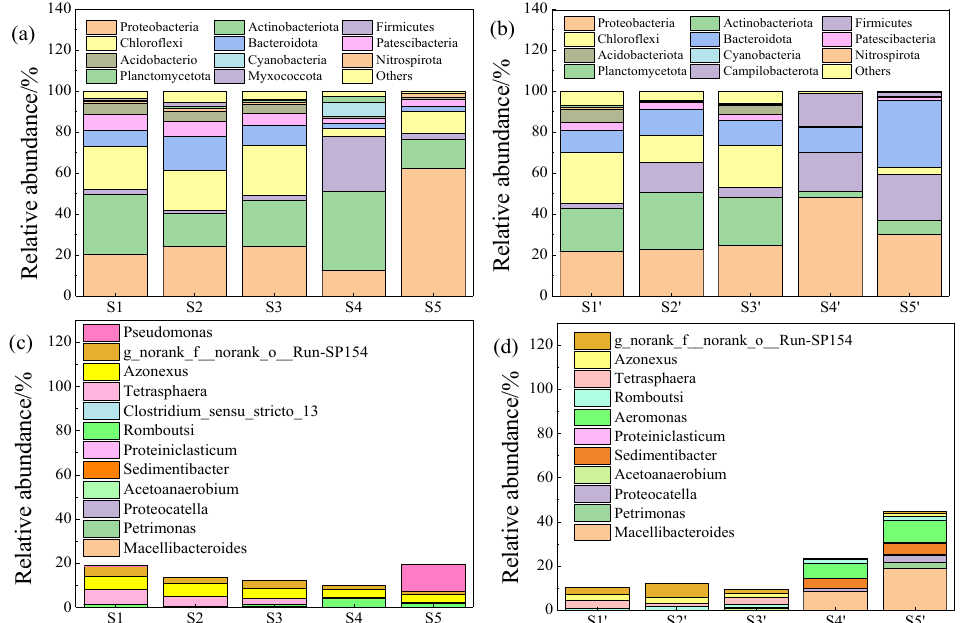
Figure 4. Effect of ferrate pretreatment and digestion on microbial proportion structure diagram (( a ) phylum-level distribution of bacterial population after pretreatment, ( b ) phylum-level distribution of bacterial population after digestion, ( c ) genus-level distribution of bacterial population after pretreatment, ( d ) genus-level distribution of bacterial population after digestion).